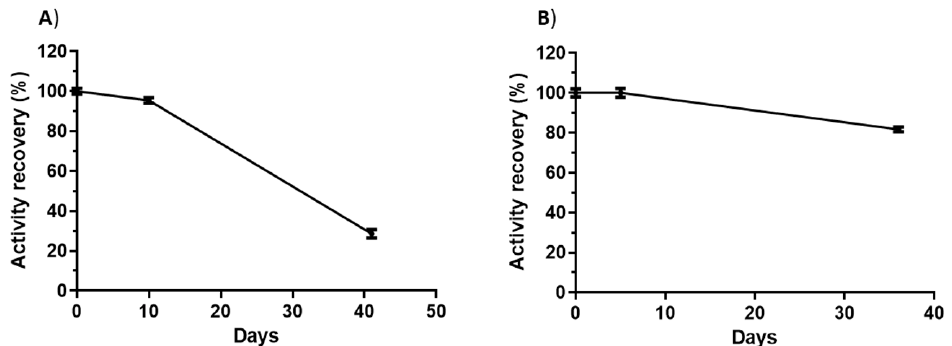
Figure 5. Maintenance of the enzymatic activity at 4 ◦ C: ( A ) ASP-liposomes and ( B ) ASP-enzymosomes. The bars show the standard errors for three replicates from one representative experiment, among the three independent experiments performed.